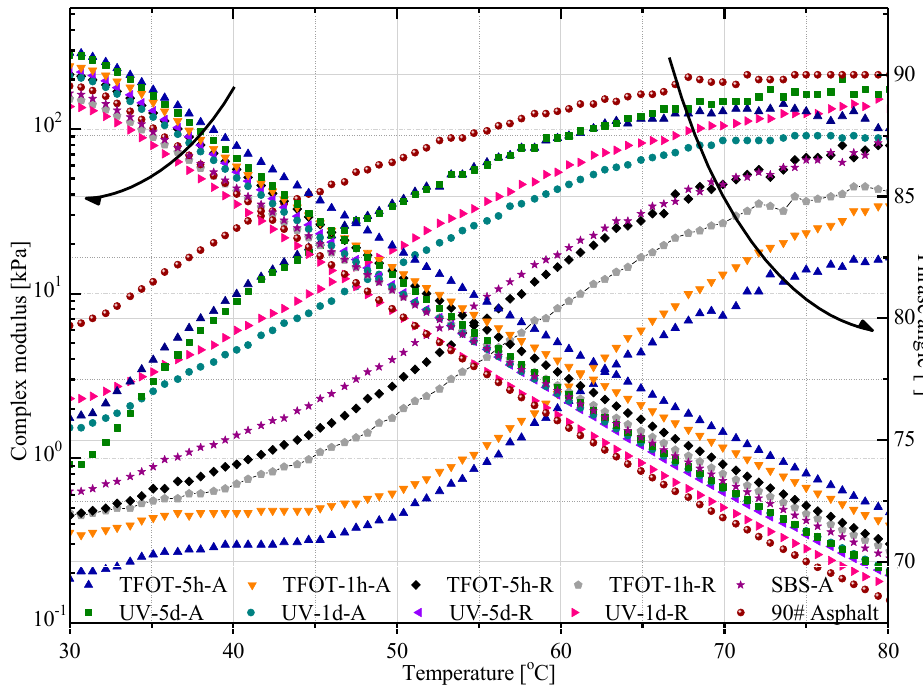
Figure 11. Changes of complex modulus and phase angle.